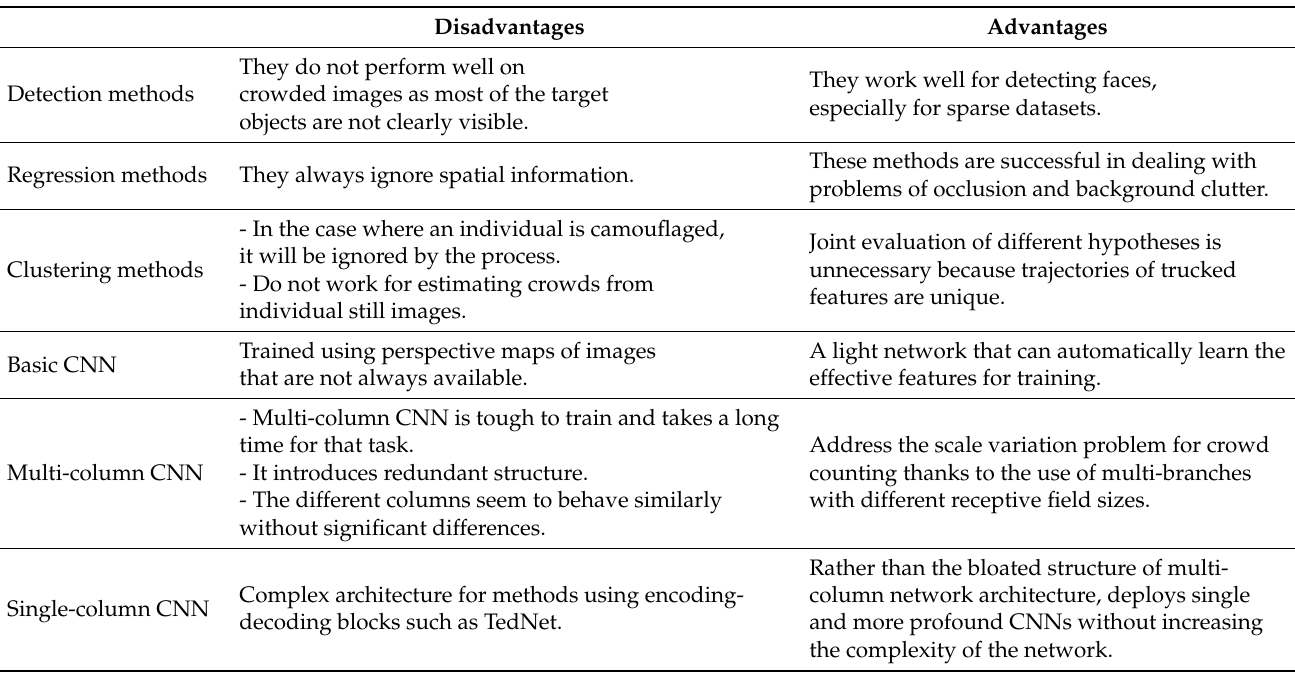
Table 3. Disadvantages and advantages of different methods that have been proposed for crowd